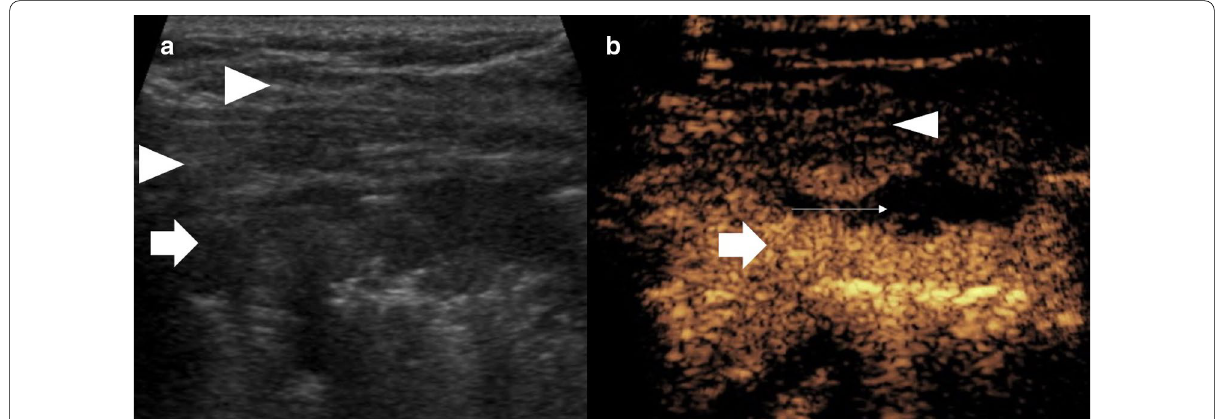
Fig. 1 Patient with pleural mesothelioma. a B mode ultrasound shows a relatively ill‑defined lesion (arrow), which is difficult to differentiate from the striated muscle at some points (arrowheads). b CEUS shows clear hyperenhancement of the lesion (arrow) defining the borders and necrotic component (thin arrow) from the straited muscle layer (arrowhead) allowing accurate targeting for an optimal biopsy